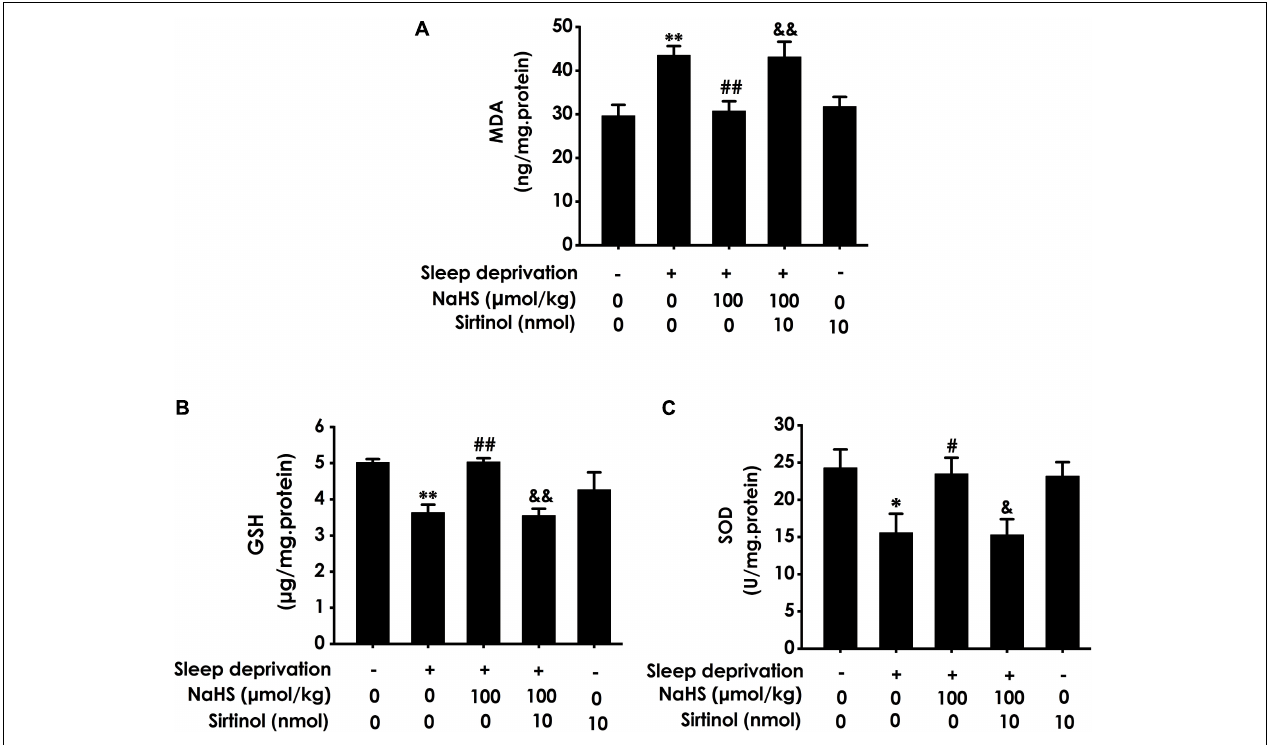
FIGURE 5 | Effect of Sirtinol on hydrogen sulfide ameliorated hippocampal oxidative stress in sleep deprivation-exposed rats. Rats were pretreated with NaHS (100 µ mol/kg/d, ip) for 7 days and then cotreated with SD and Sirtinol (10 nmol/d, icv) for 72 h. The levels of MDA (A) and GSH (B) in the hippocampus were detected by ELISA kit. The activity of SOD (C) in the hippocampus was measured by the NBT assay kit. Values are the means ± SEM ( n = 3). ∗ P < 0.05, ∗∗ P < 0.01, vs. control; # P < 0.05, ## P < 0.01, vs. SD-treated alone group; & P < 0.05, && P < 0.01, vs. cotreated with SD and NaHS (100 µ mol/kg/d, i.p.) group.